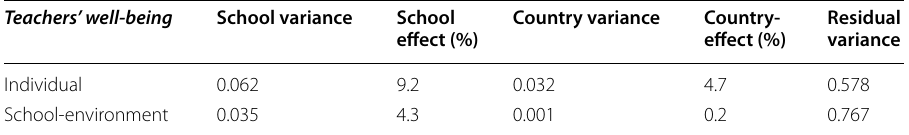
Table 5 PVRE by country and by school in teachers’ well-being Teachers’ well-being